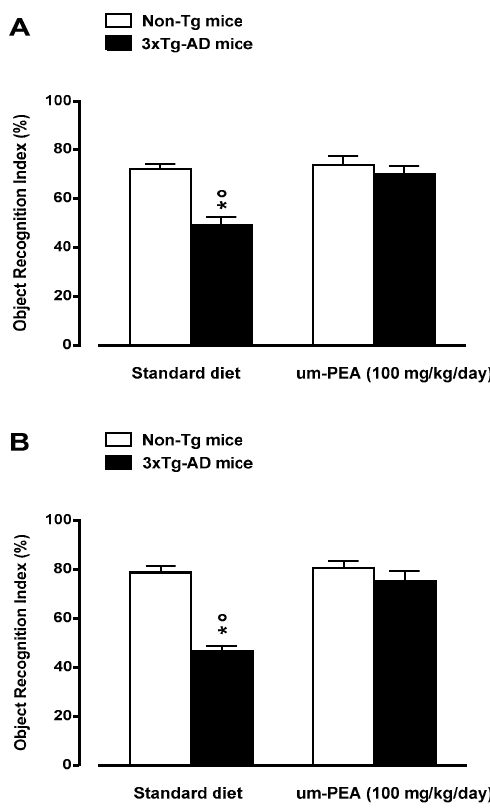
Figure 2. Oral ultramicronized palmitoylethanolamide (um-PEA) treatment rescues short-(3 h;